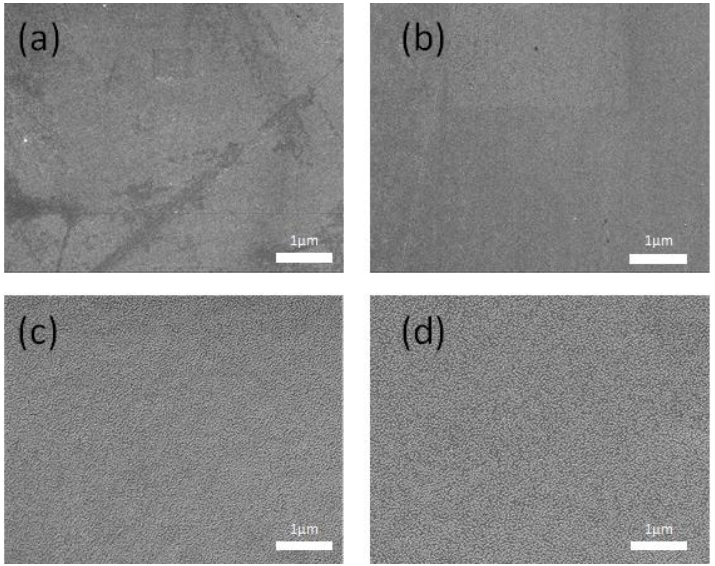
Figure 8. Scanning electron microscopy (SEM) images of the surface of ( a ) PVA and ( b ) LBT/PVA-2 films and cross section of ( c ) PVA and ( d ) LBT/PVA-2 films.